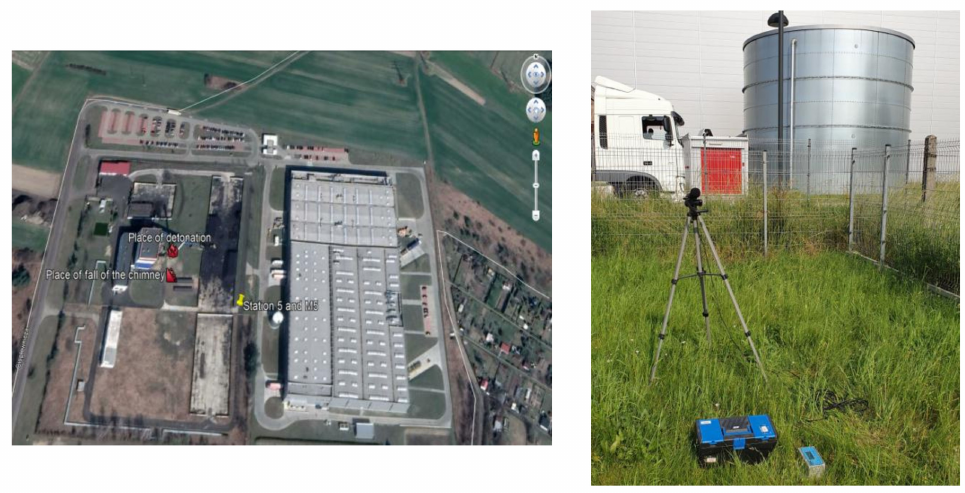
Figure 14. Blasting site and measurement